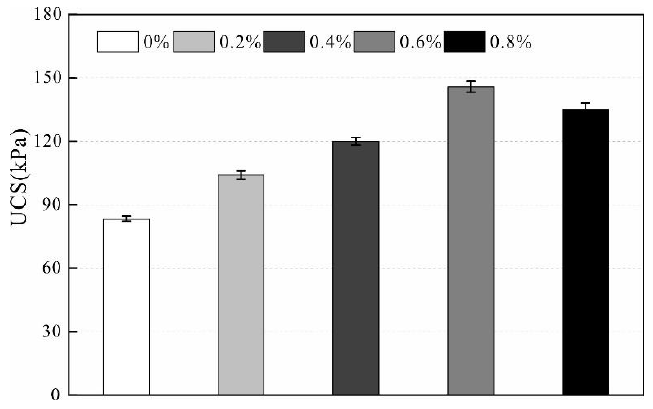
Figure 5. Unconfined compressive strength of dry samples.